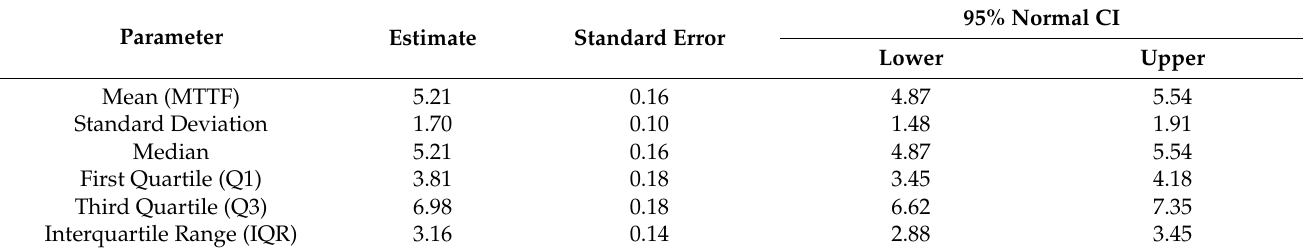
Table 4. Estimation of the parameters for the type II milling